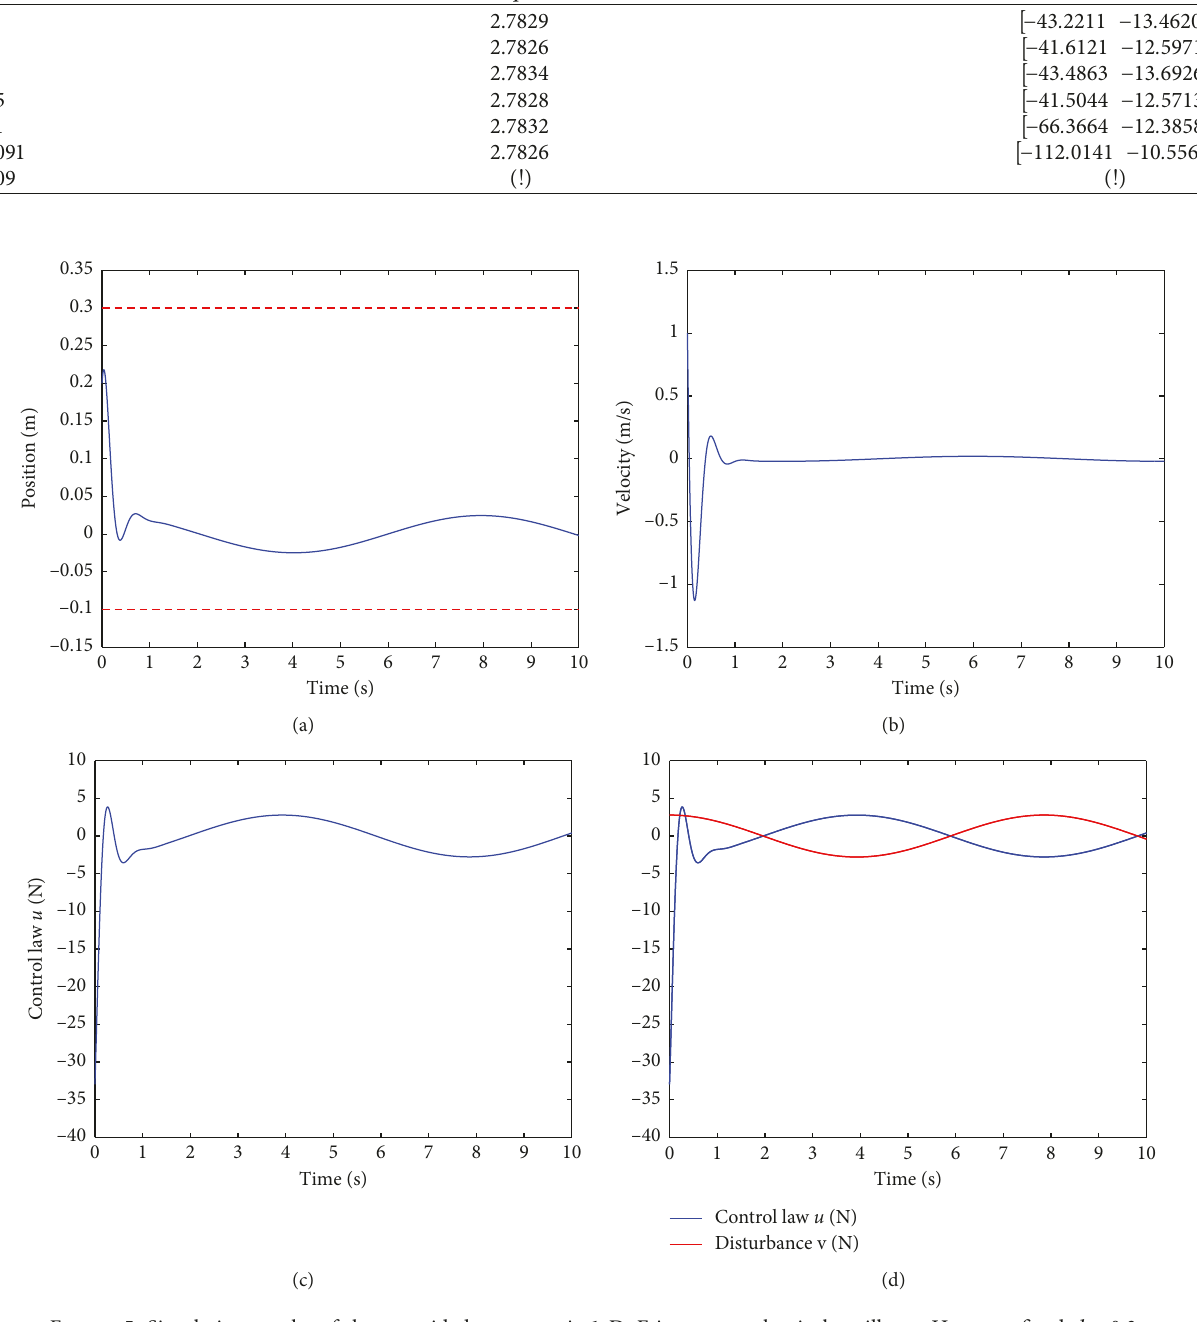
Figure 5: Simulation results of the two-sided asymmetric 1-DoF impact mechanical oscillator. Here, we fixed d � 0 .